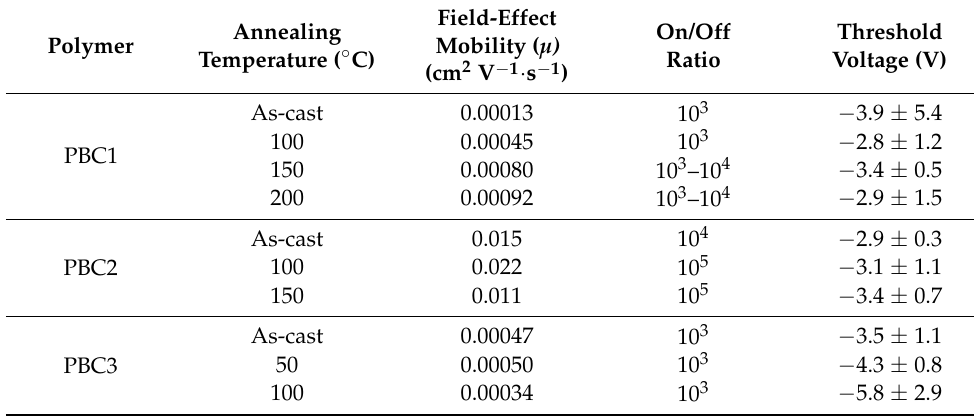
Table 2. Summary of OTFT